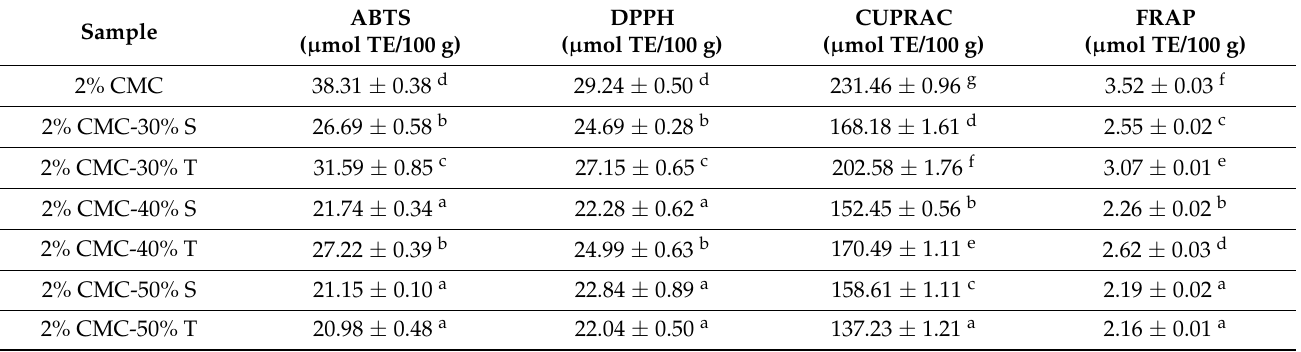
Table 6. Antioxidant activity (FRAP, CUPRAC, DPPH, and ABTS assays) of chokeberry hydrogels and chokeberry juice.